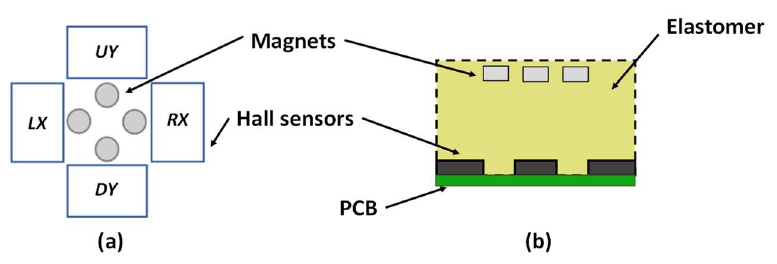
Figure 1. Schematic design of the proposed magnetic tactile sensor: ( a ) top view, ( b ) side view.